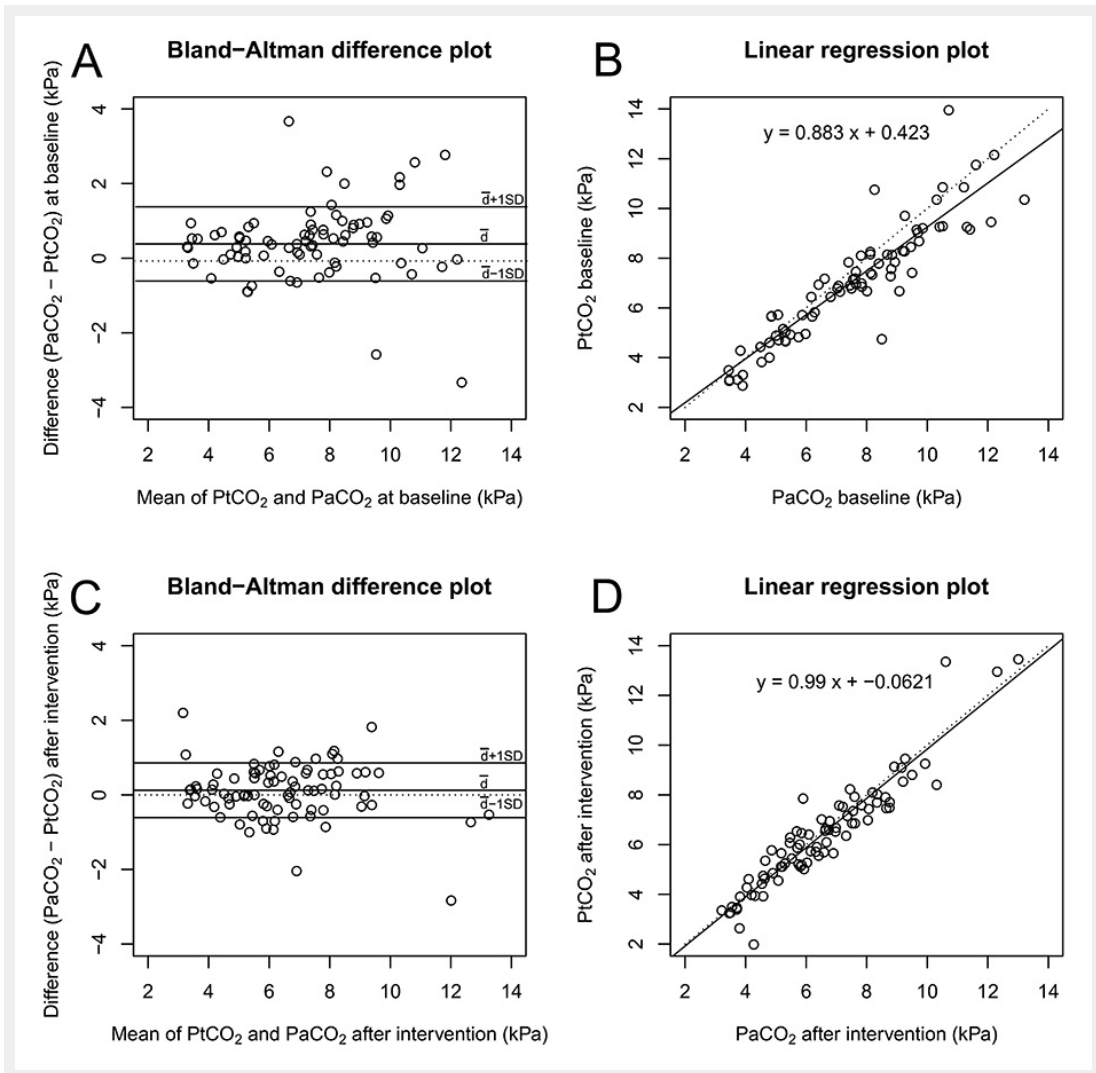
Figure 3 Comparison of transcutaneous and invasive PaCO 2 at baseline and after intervention. Measurements were compared using both a Bland- Altman plot (A, C) and a linear regression plot (B, D). A and B at baseline, C and D after NIV. The Bland-Altman plot displays the mean bias and limits of agreement (solid lines). The linear regression plot displays the line of best fit (solid line) and the identity line (dashed